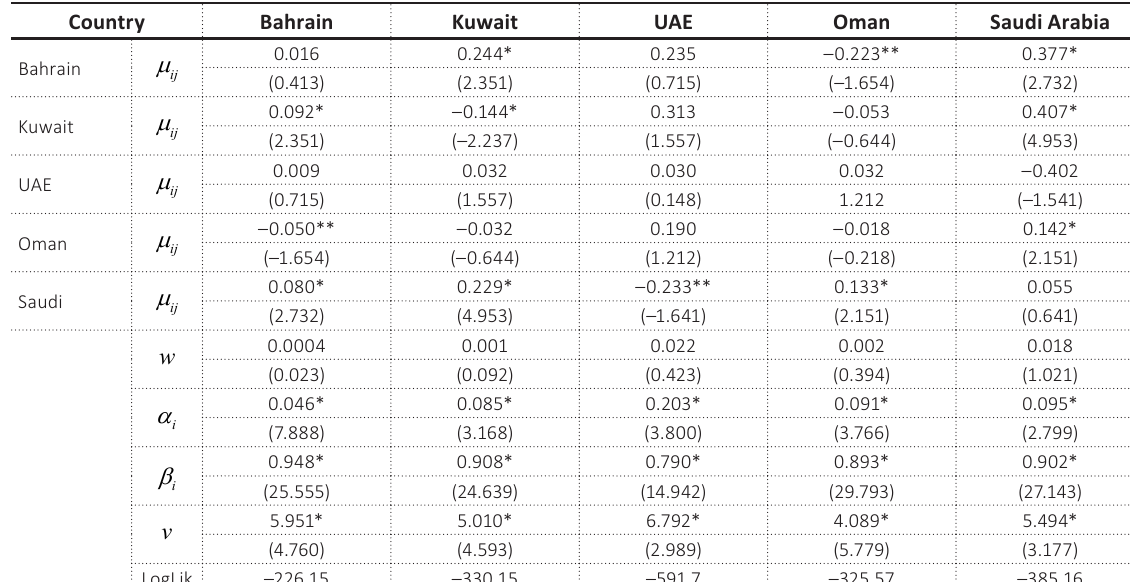
Table 2. Estimation